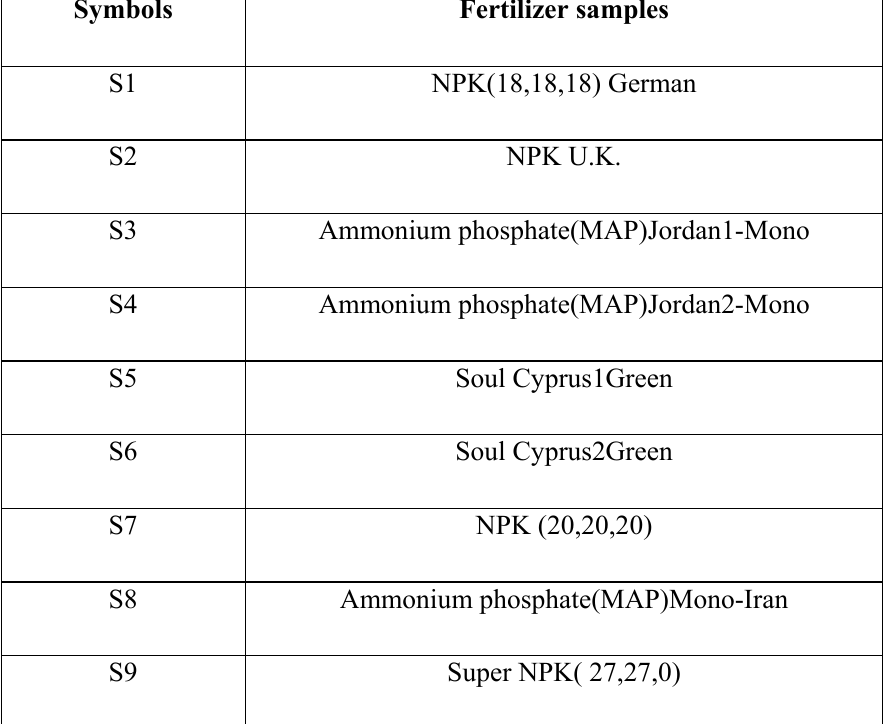
Table 1: Symbols of fertilizer samples.